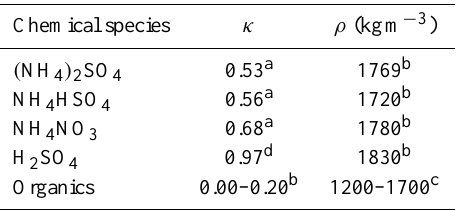
Table 1. Hygroscopic parameters κ and densities ρ used in the κ - Köhler theory (Eq.